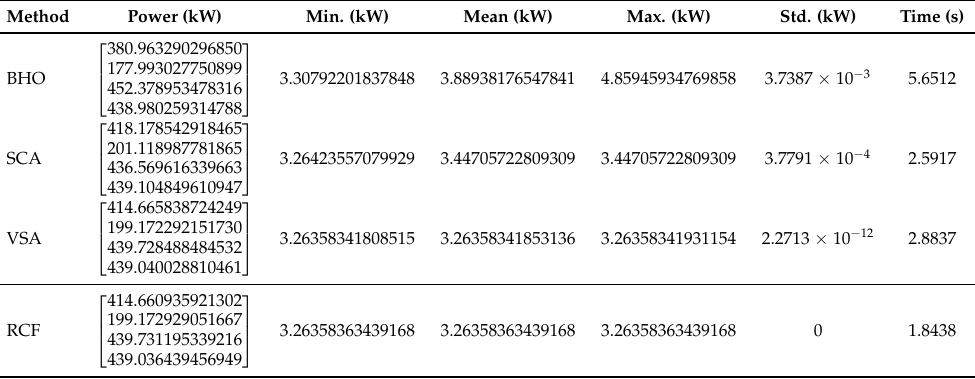
Table 3. OPF solution for the 85-bus grid using different methodologies.